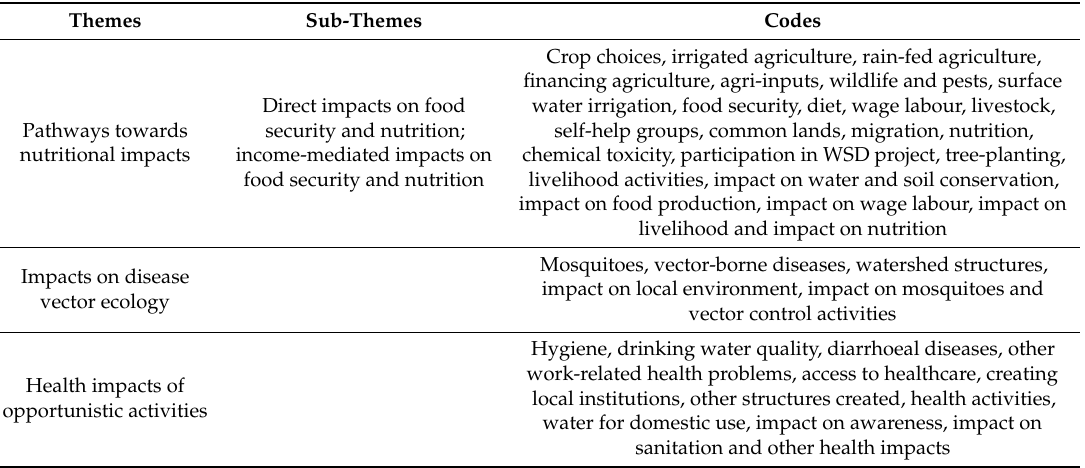
Table 2. List of codes and themes used during the analysis.